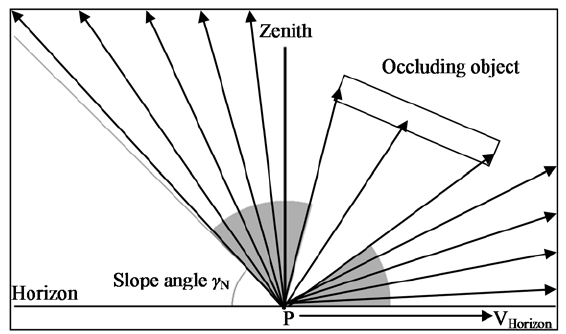
Figure 2. Illustration of the SVF and obstructing features at P.